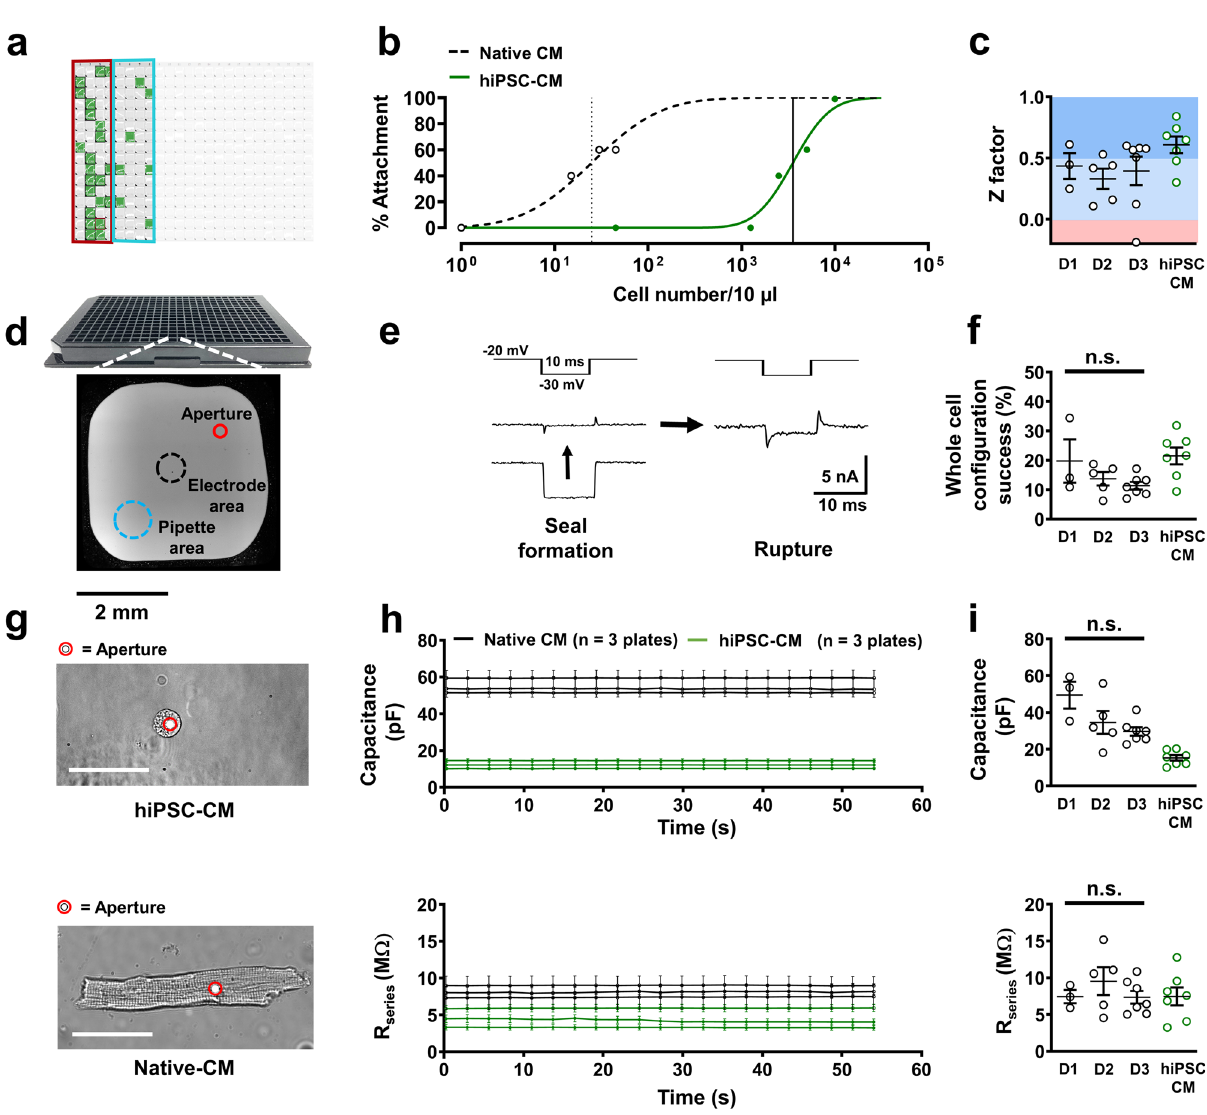
Fig. 2 Quality control of automated patch-clamp of native atrial and ventricular cardiomyocytes (Native CM). a Representative 384-well APC chip partially fi lled with native CMs is shown as a screenshot of Nanion DataControl 384 software with unused areas shaded out. Green boxes represent successful whole-cell con fi guration during L-type calcium current ( I Ca,L ) measurement. Red and blue rings indicate atrial and ventricular CM partitions respectively. b Cellular density-dependent optical attachment rates of native ventricular cardiomyocytes and human ventricular induced pluripotent stem cell-derived cardiomyocytes (hiPSC-CM) onto the patch-clamp aperture. c Z factor analysis of individual runs for assessment of reproducibility ( I Ca,L currents) over three separate experimental days (D1, D2, D3) and therefore three animals. d NPC-384T chip with a photomicrograph of a single well with locations of interest labeled. e Representative membrane resistance during seal formation and membrane rupture of a native CM in the presence of a membrane test pulse. f Percentage success rates for whole-cell con fi guration from single plates of native CMs over three separate experimental days and hiPSC-CMs used in this protocol during I Ca,L acquisition. P = 0.210 g Photomicrograph of an attached ventricular hiPSC-CM and ventricular native CM. The patch-clamp aperture is obscured by the cell. Scale bar denotes 50 µ m. h Time course of membrane capacitance and series resistance ( R series ) in hiPSC- CMs (3 plates, same day) and native CMs (3 plates, same day) over successive I Ca,L experiments. i Cellular capacitance ( P = 0.054) and R series ( P = 0.871) averages from single plates over three separate experimental days. Data are mean ± SEM. n = mean of 24 wells ( b ) or single plates ( c , f , h , i